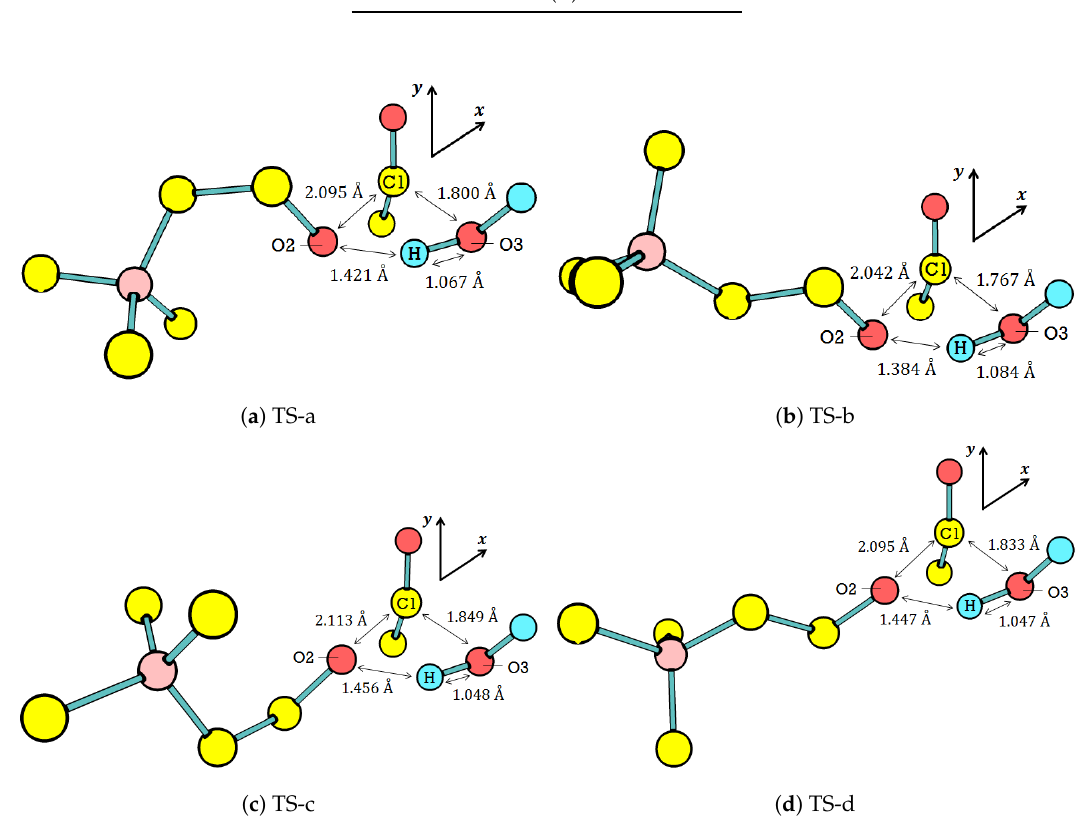
Figure 5. The four possible TS